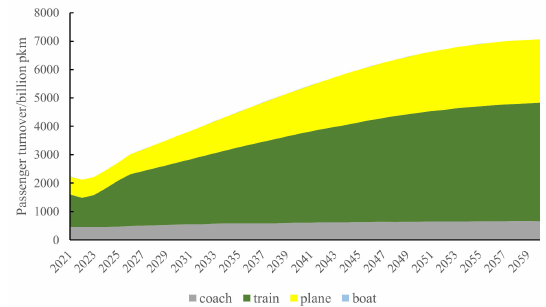
Figure 6. Inter-city passenger turnover.